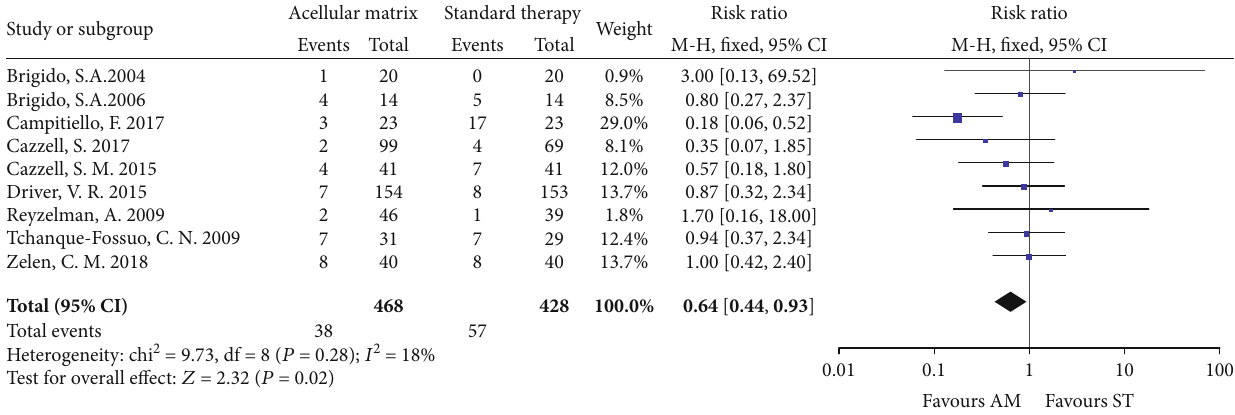
Figure 7: Forest plot of adverse events.